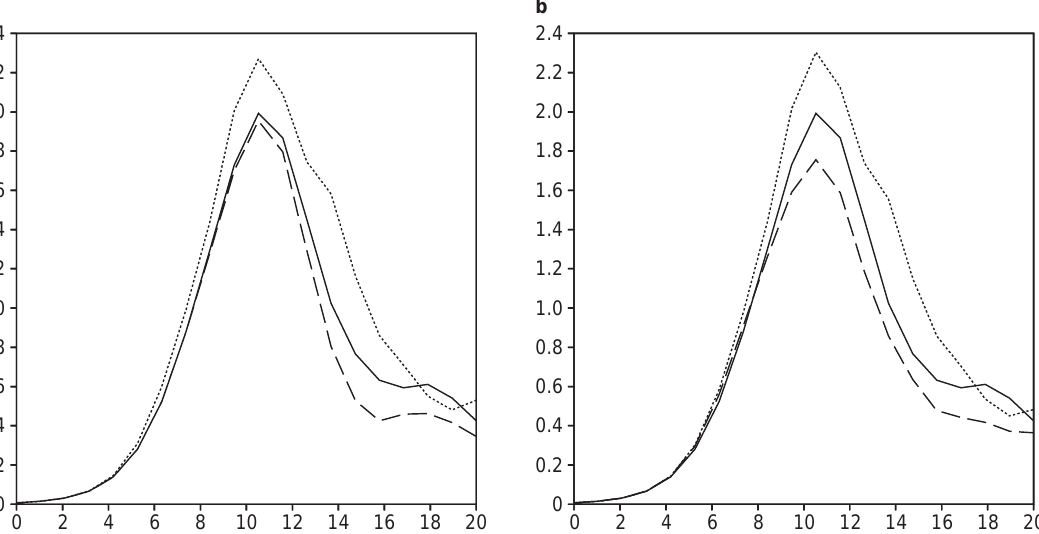
Fig. 3a,b. Time development of eddy kinetic energy, K e for five life cycle experiments. a DRY ( solid curve ), G60 ( dashed ) and G100 ( dotted ). b DRY ( solid curve ), G100ST60 ( dashed ) and G100ML60 ( dotted ). Values plotted in units of 10 5 J m (cid:255)